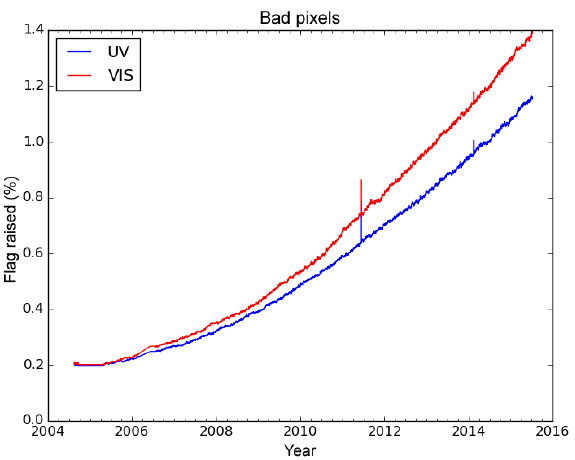
Figure 16. Bad-pixel flagging over the mission time for unbinned pixels. The binned L1B pixels have an 8 times higher flagging rate.